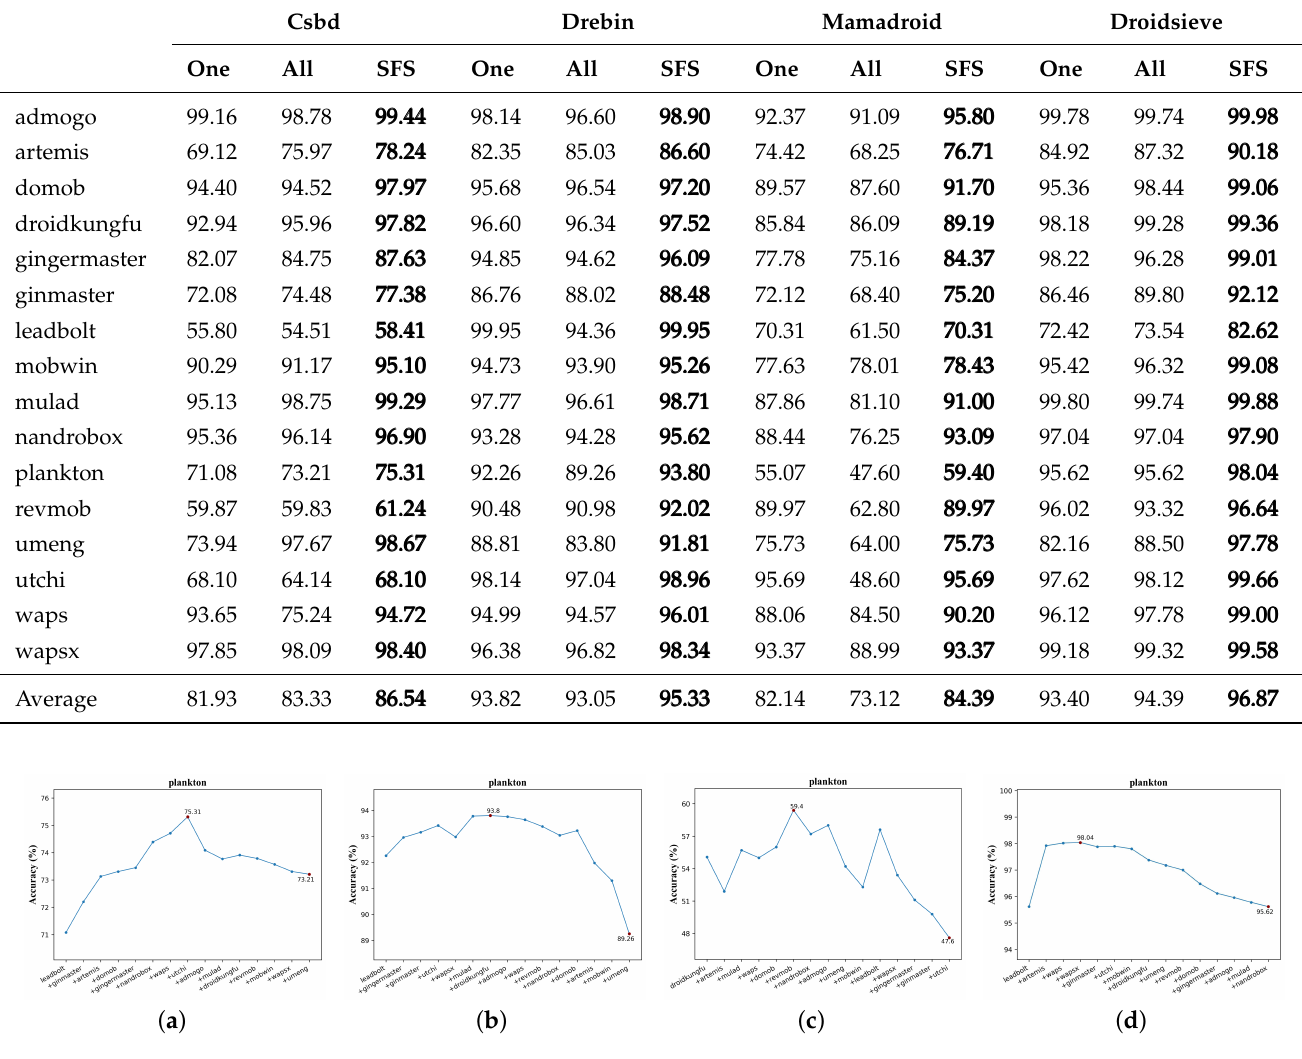
Table 9. The comparison of zero-resource malware family detection. The number in bolds shows the best results.